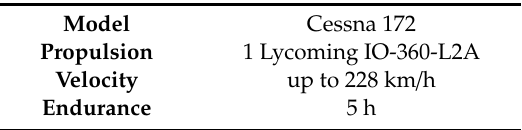
Table 1. Airplane parameters.